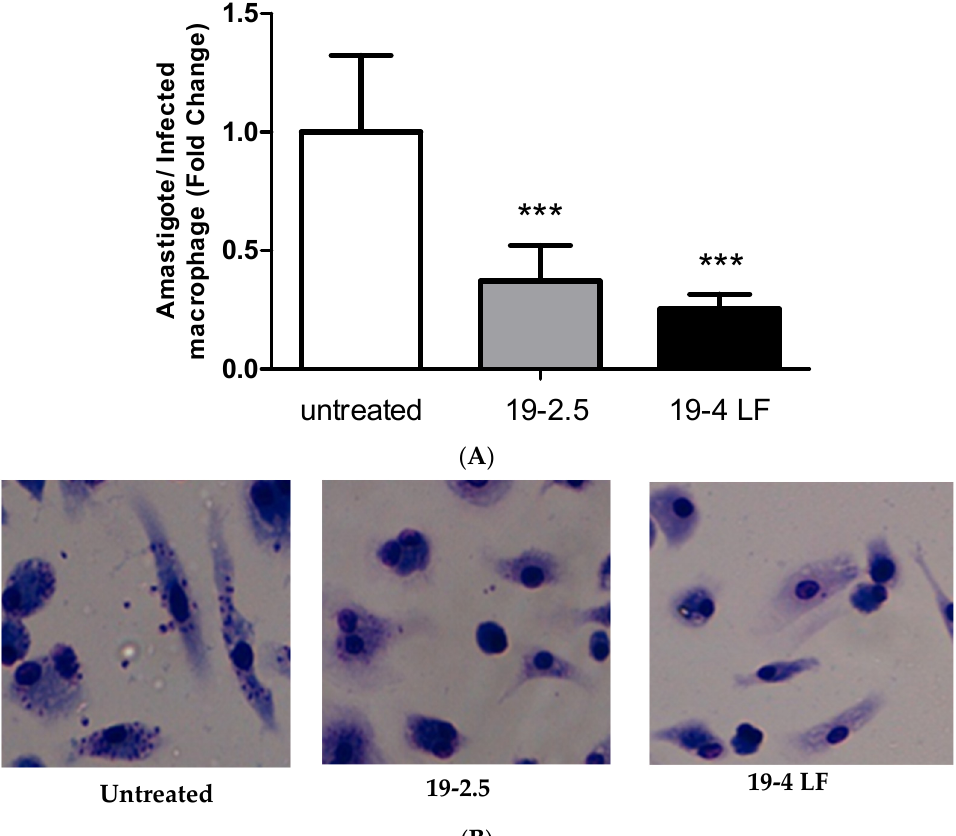
Figure 1. Leishmanicidal activity of 19-2.5 (1 µg/mL) and 19-4 LF (1 µg/mL) against intramacrophage amastigotes ( A ). Bars represent the mean ± SD values from three independent experiments. Significant reductions in the number of amastigotes per infected macrophage were detected when compared to untreated controls (***, p < 0.001). Representative images of untreated infected cells and infected macrophages treated with 1 µg/mL of 19-2.5 or 19-4LF peptides ( B ).